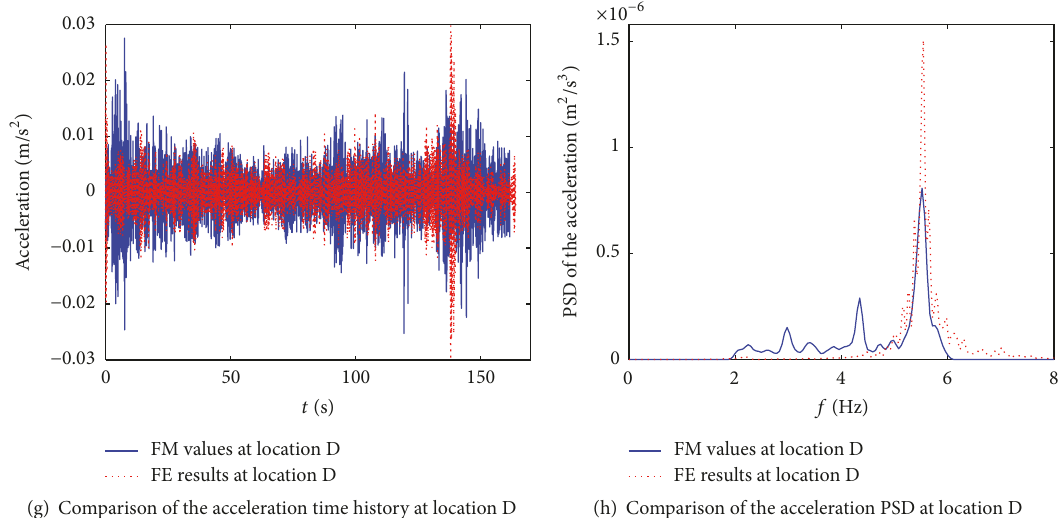
Figure 9: Comparison of the results of the finite element analysis calculation and the field measurements at the different measurement loca- tions.